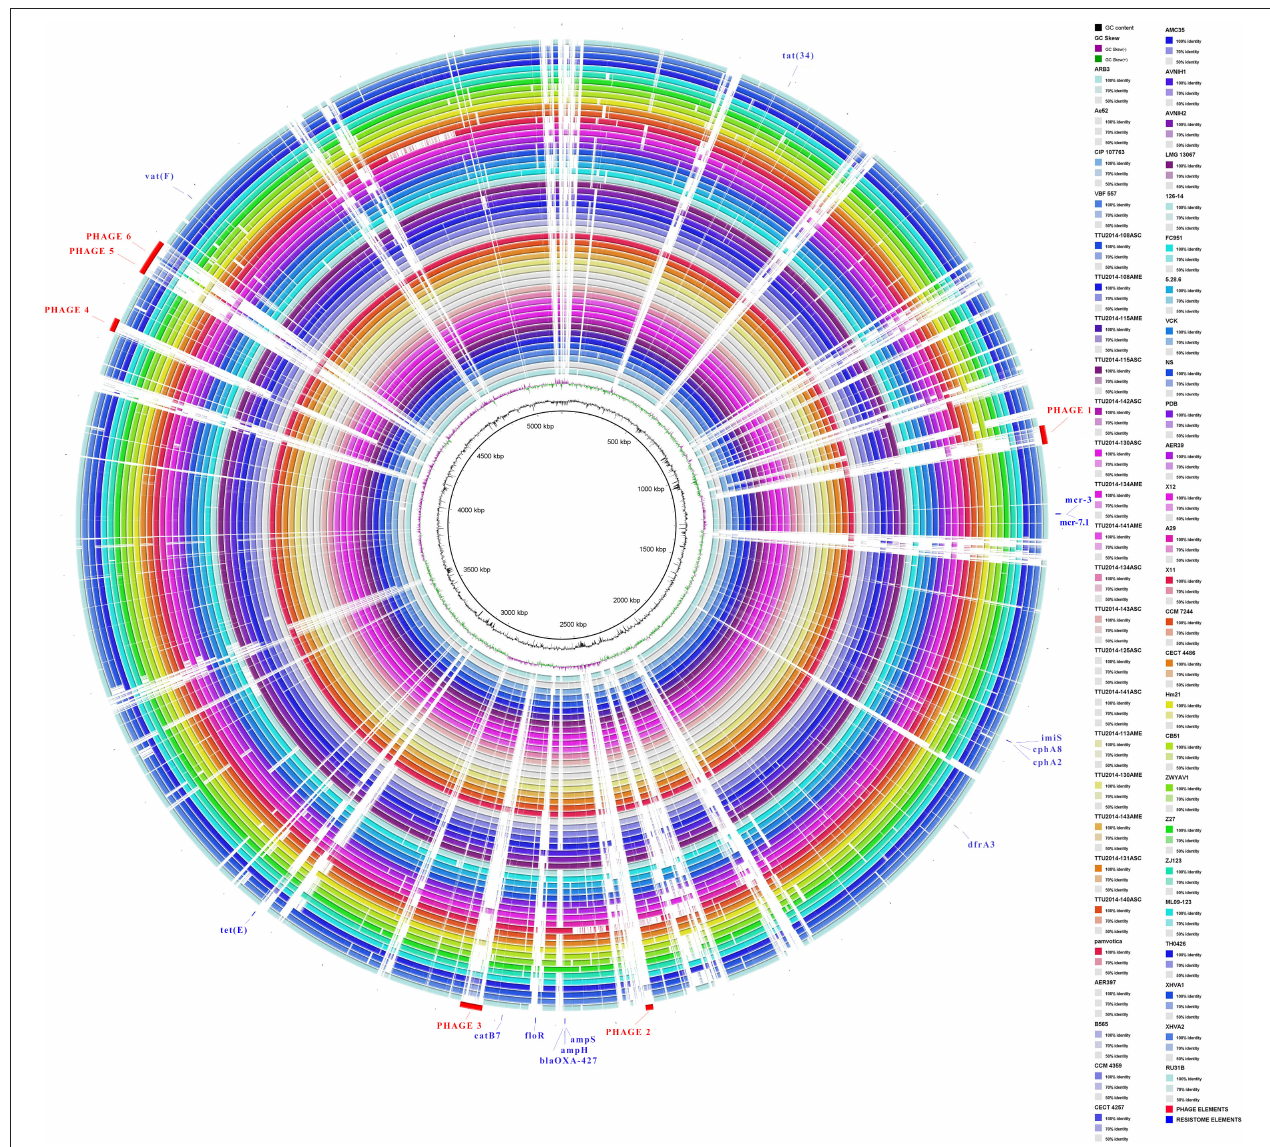
FIGURE 3 | Comparative circular map of the A. veronii MS-17-88 genome. Phage regions are highlighted with red color: phage region-1 encodes 41 proteins (31.8Kb), phage region-2 encodes 12 proteins (12.6Kb), phage region-3 encodes 39 proteins (37.7Kb), phage region-4 encodes 31 proteins (22.9Kb), phage region-5 encodes 45 proteins (48.6Kb), and phage region-6 encodes 30 proteins